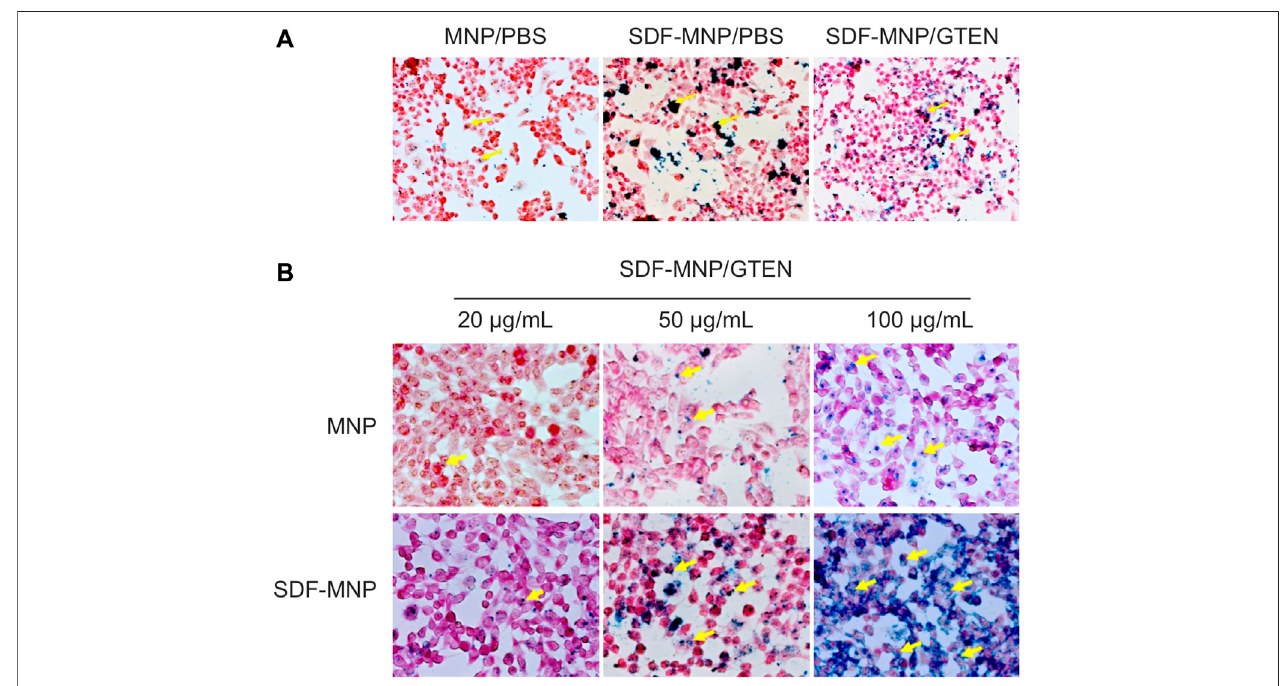
FIGURE4| Perlsstainoftotalattached ironorironuptakeofMSCsincubatedwithMNPorSDF-MNP(magni fi cation:×400). (A) SDF-MNPresuspended withPBS or GTEN and incubated with iPSC-MSCs. (B) iPSC-MSCs were treated with SDF-MNP/GTEN at different fi nal concentrations. Then, total attached iron or iron uptake was determined using Perls reagent. Red signal is a stained cell, and yellow arrows pointing to dark blue signals represent iron. They showed a more obvious, well- distributed iron signal, which increased in a concentration dependent